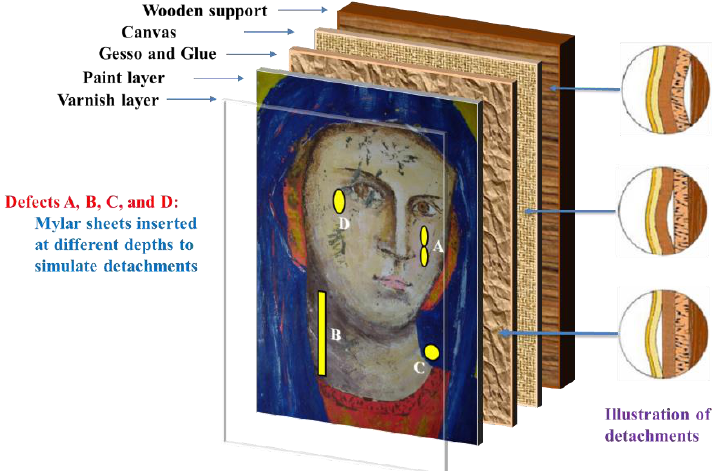
Figure 3. Structure of Madonna panel painting. The Figure was redrawn considering Ref. [55].